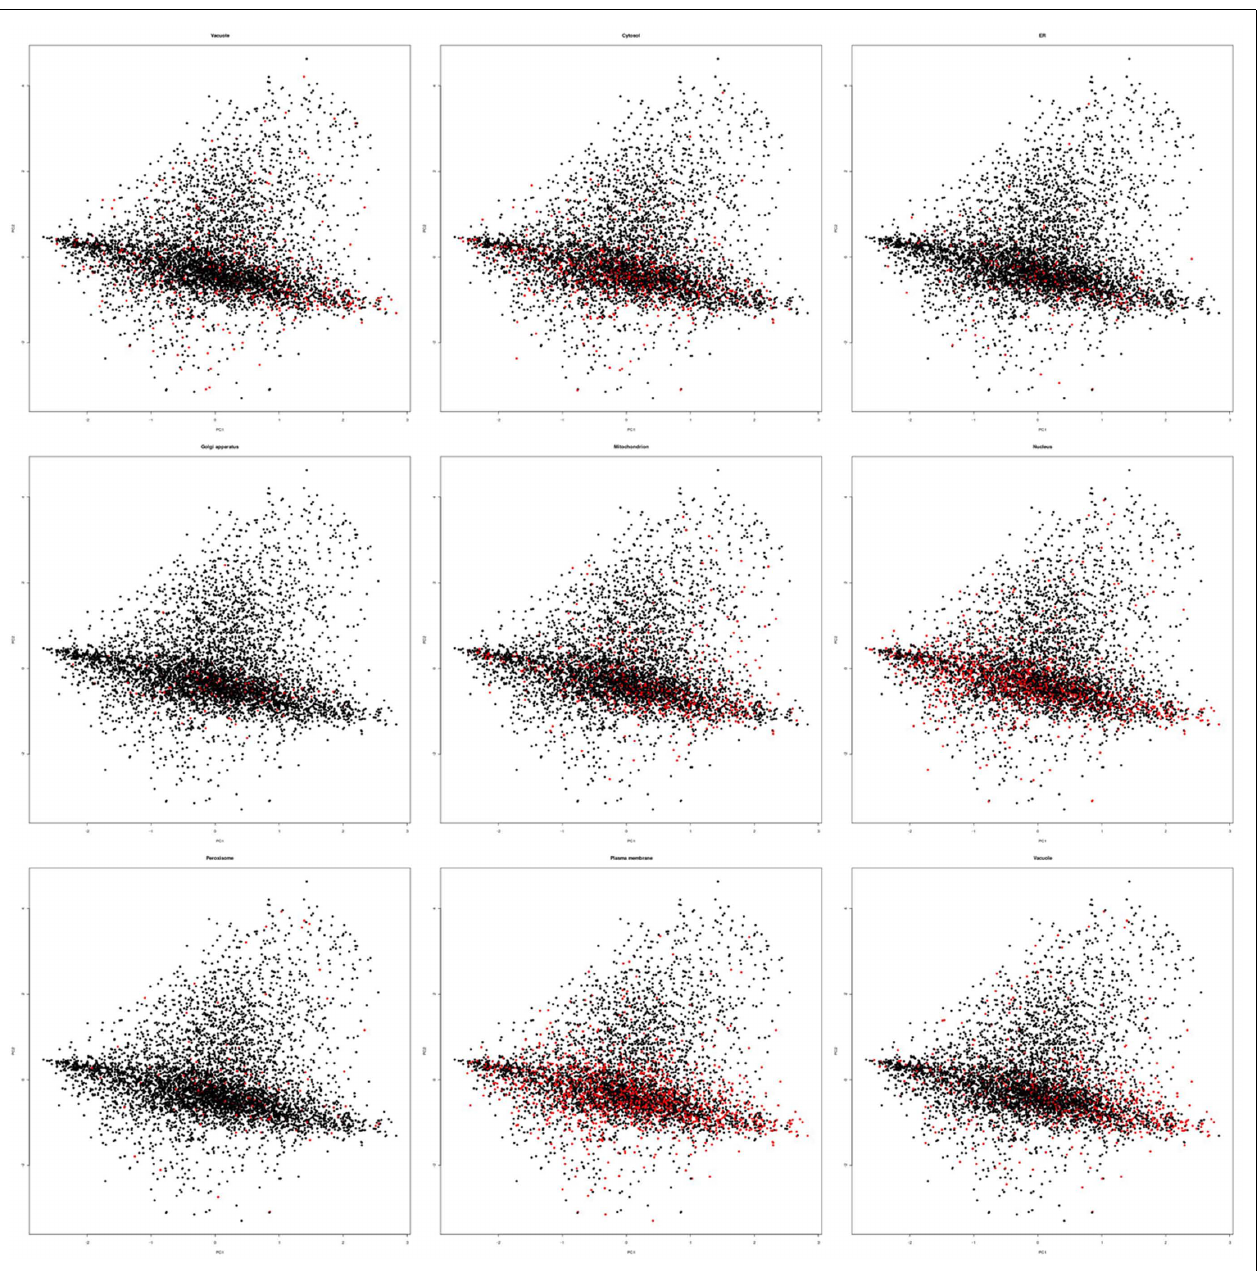
FIGUREA1 | Principle component analysis plots for all compartments. Exemplary principal component plots showing proteins belonging to a compartment in red and all other proteins in black. In each case 500 array slides were randomly sampled for the PCA plots and displayed exactly as in Figure 1 .